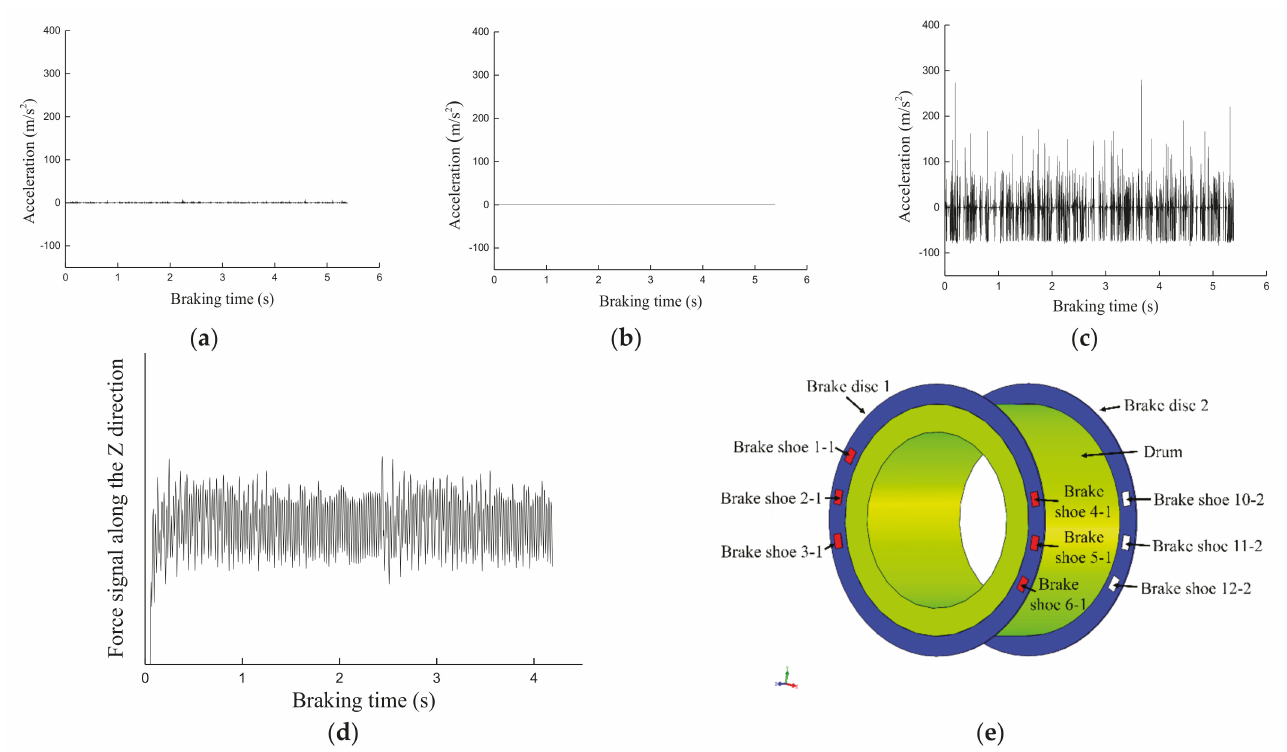
Figure 5. Evolutions of acceleration and brake force of brake shoe and brake shoe numbering. ( a ) Theoretical acceleration in the X direction; ( b ) theoretical acceleration in the Y direction; ( c ) theoretical acceleration in the Z direction; ( d ) experimental brake force in the Z direction; ( e ) schematic diagram of brake shoe